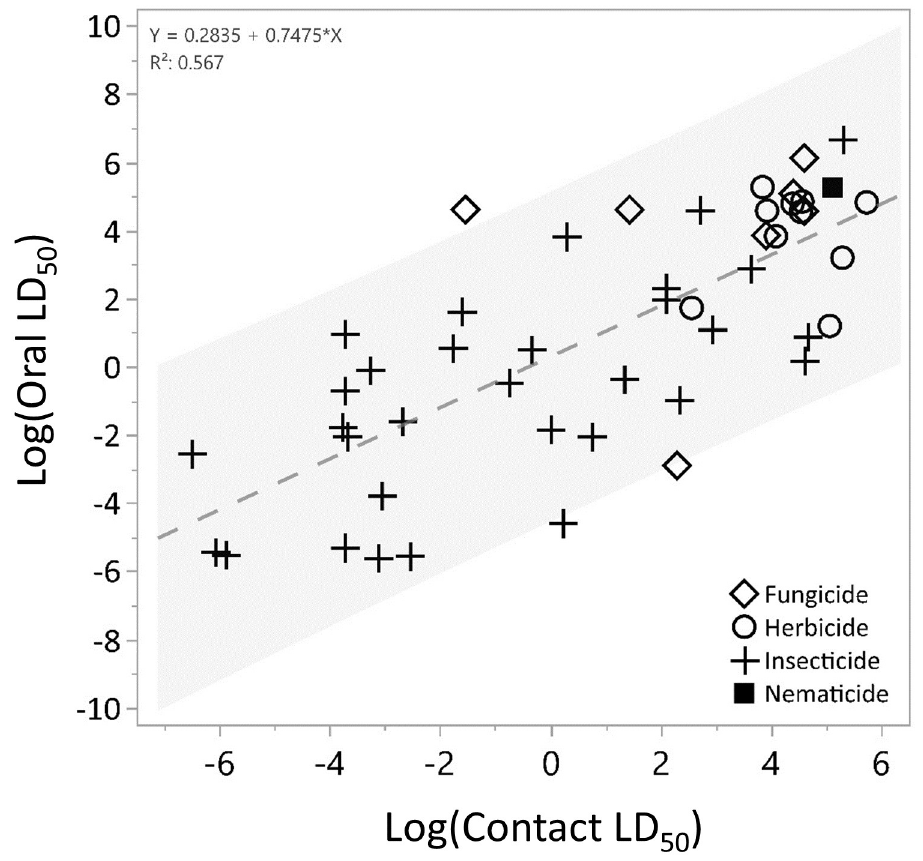
Fig 2. Linear regression between log-transformed adult acute oral and acute contact LD 50 values (Spearman’s ρ = 0.74, p < 0.0001, n = 49 study pairs) by chemical. The shaded region illustrates the predicted 95% confidence interval.